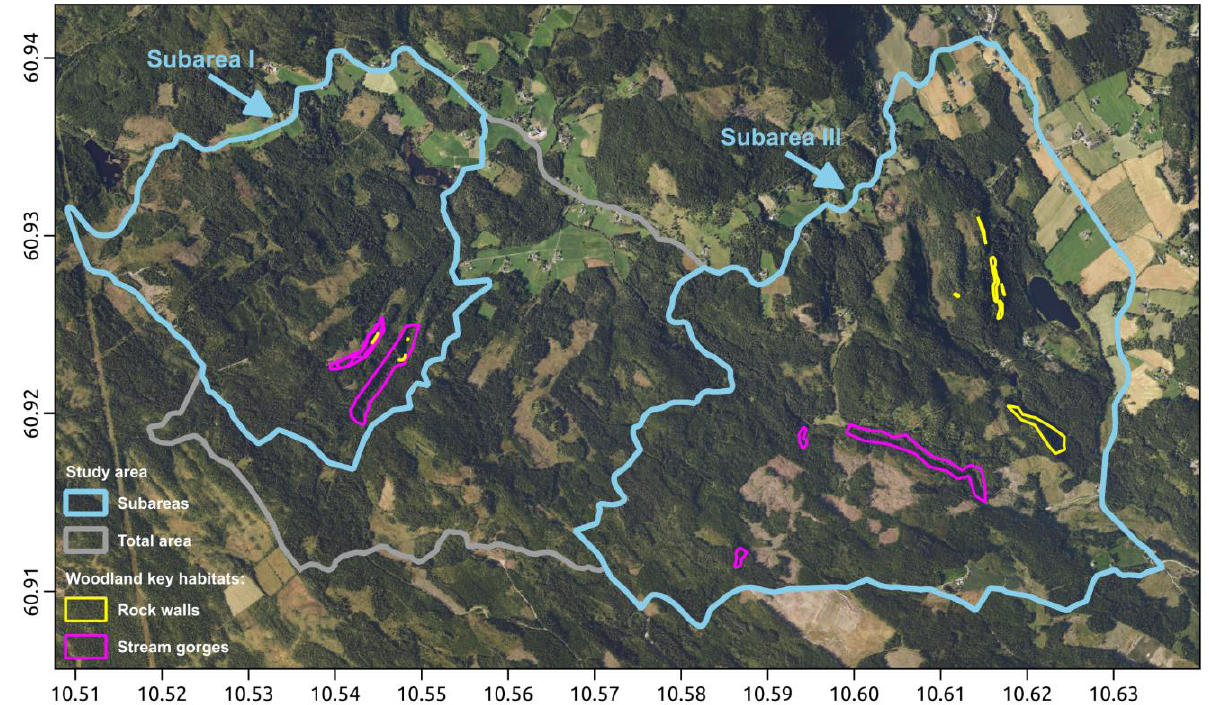
Figure 1. Study area and location of field delineated rock walls and stream gorges.